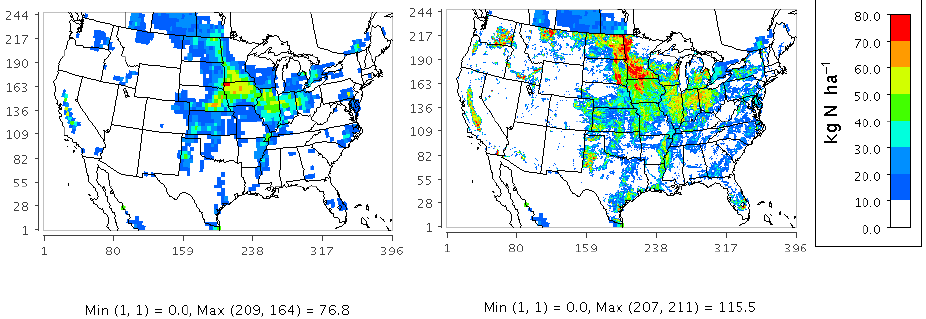
Figure 4. Potter et al. (2010) (left) and EPIC (right) annual fertilizer applications (kgNha − 1 ). Since the EPIC modeled is only for the USA, Potter et al. (2010) is used in both cases to represent Canada and Mexico.